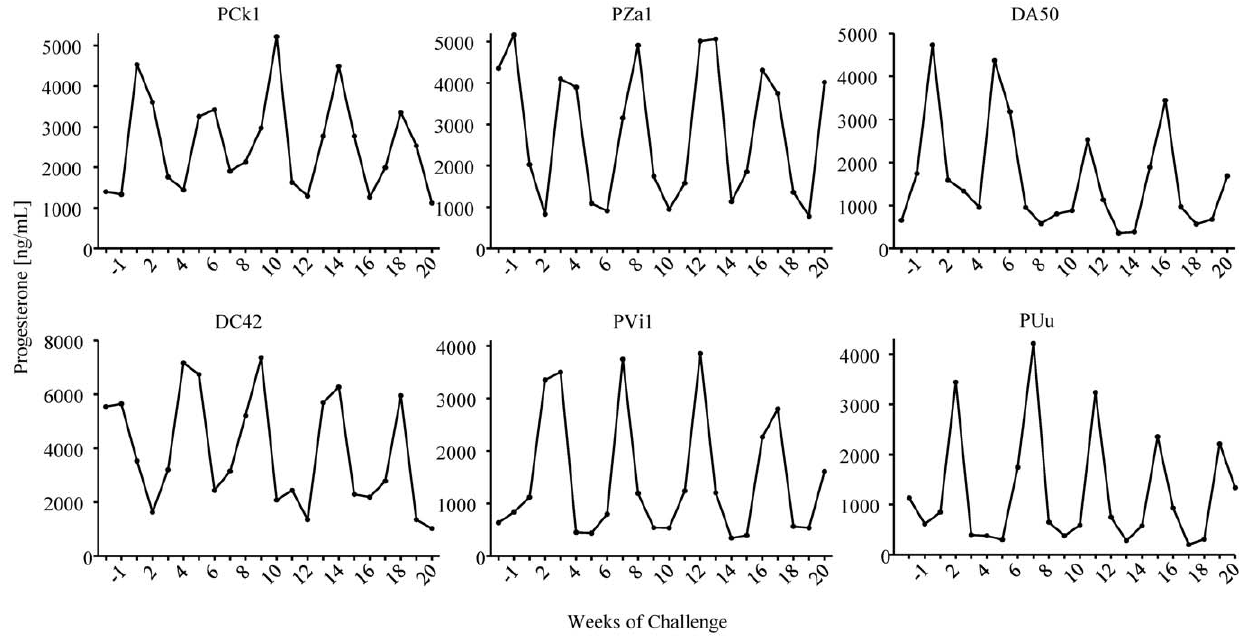
Figure 3. Plasma progesterone levels in macaques receiving oral Truvada. Animals remained protected from infection for an average of 4 complete menstrual cycles as indicated by the fluctuations in progesterone levels overtime.